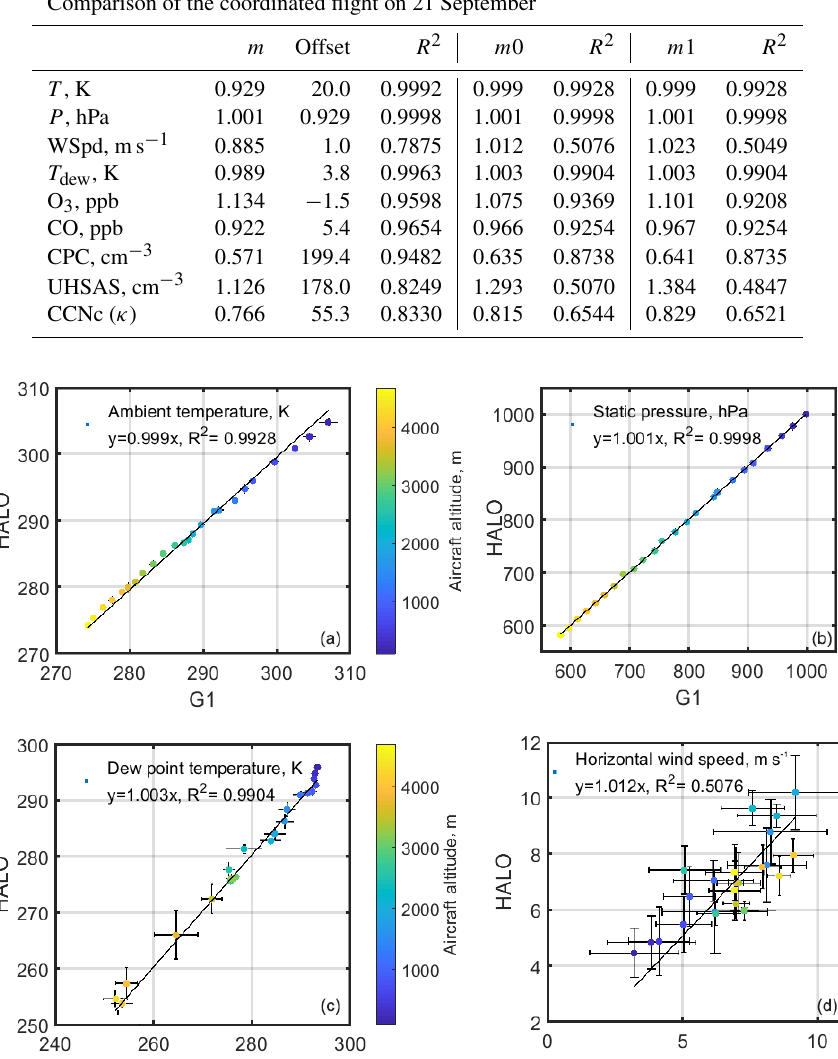
Table 4. Summary of three statistics analysis of data between in situ measurements on 21 September.